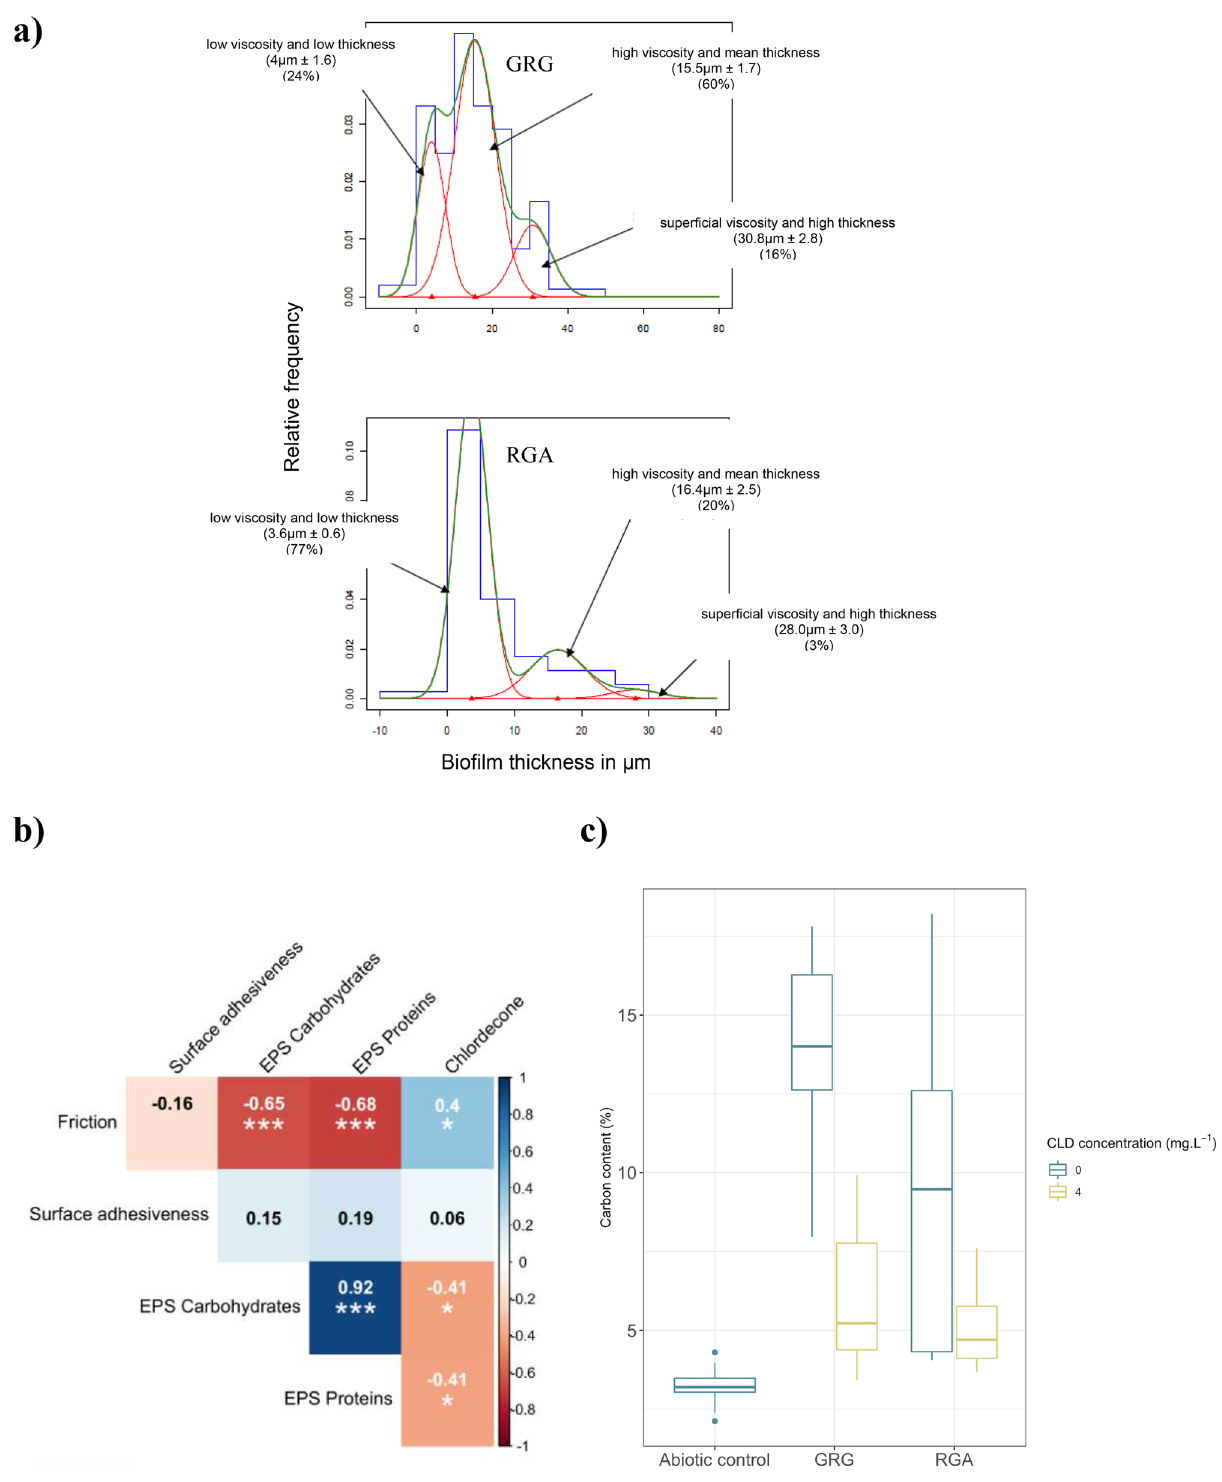
Figure 5. ( a ) biofilm grown in a contaminated (GRG), or non-contaminated (RGA) environments during 21 days, combination of viscoelasticity information upon thickness (histogram) results, ( b ) Correlogram of the main physico-chemical parameters of epilithic biofilms, ( c ) Carbon content (in percent) detected by Energy- Dispersive X-ray spectroscopy (EDXs) analysis applied on samples obtained from the microcosm